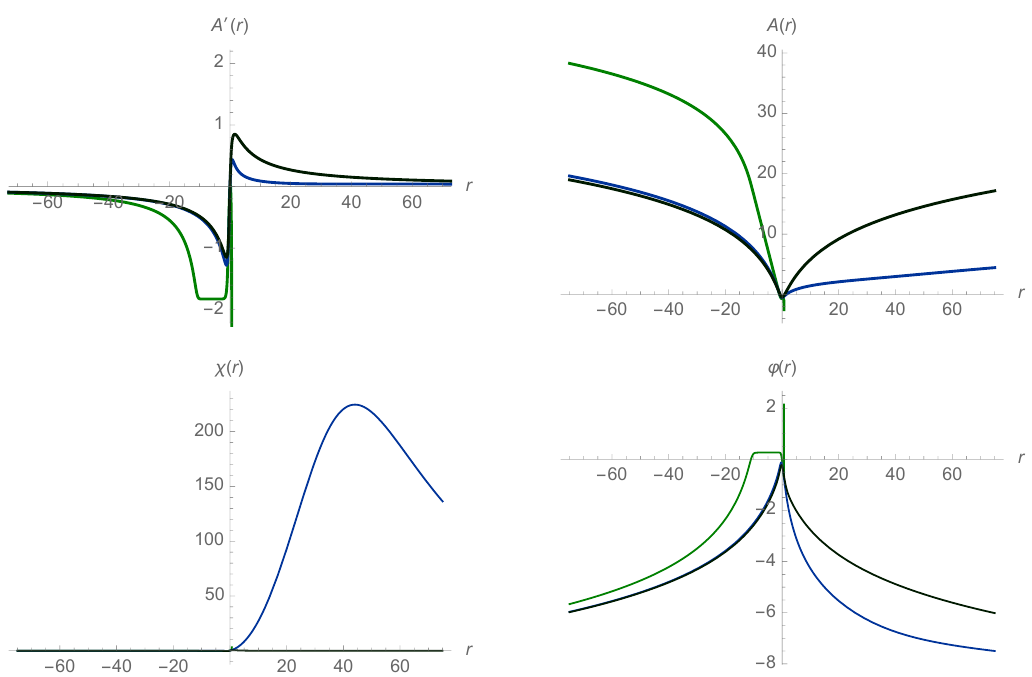
Figure 7. N = 1 Janus solution with G 2 symmetry interpolates between SYM and a singularity with an intermediate G 2 conformal phase (green). The solutions shown by black and blue lines describe SYM/SYM interfaces.